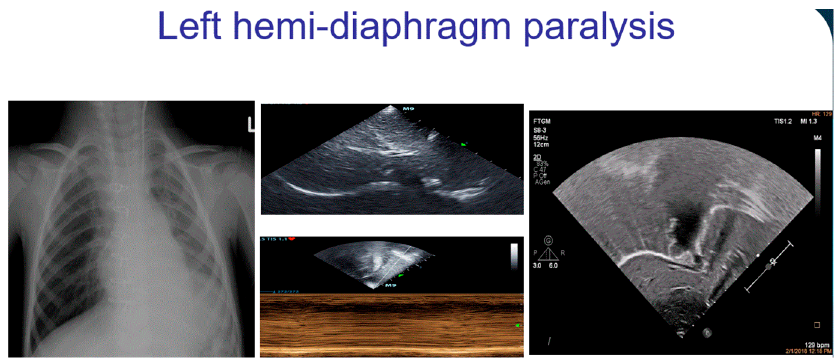
Figure 6. And Video S2: A left hemidiaphragm paralysis can be visualized by chest X-ray (left side) and confirmed by echographic analysis of diaphragm by subcostal view. In the middle, a paradoxical motion of the diaphragm can be appreciated in M-mode, and on the right image, the left hemidiaphragm lifted can be appreciated (Video S2).